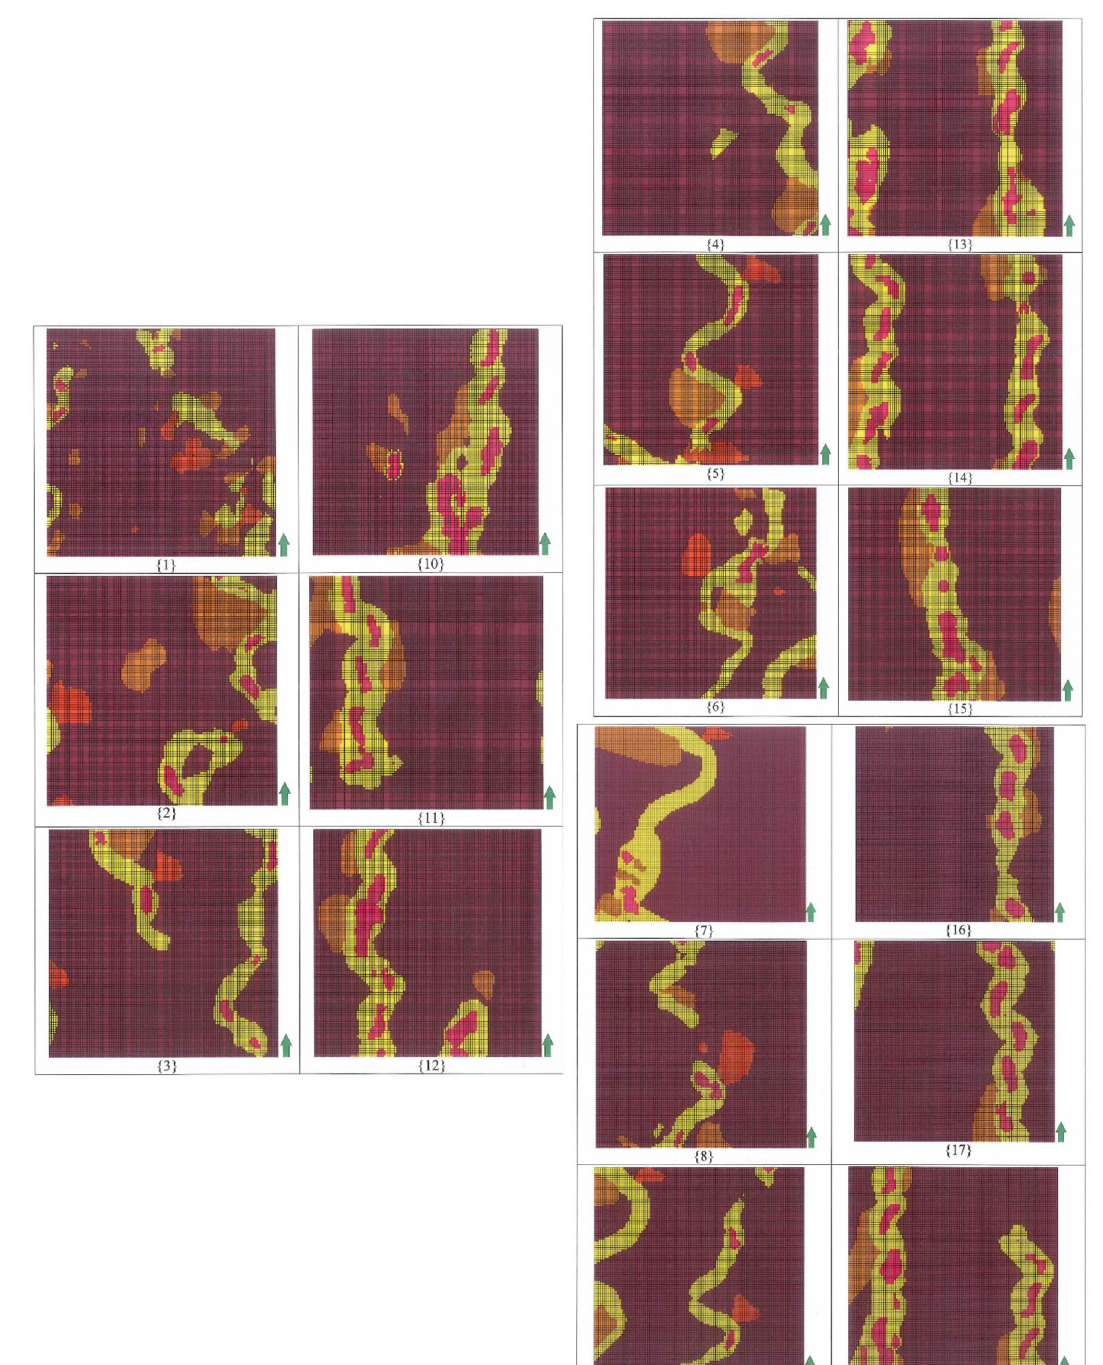
Fig. 19 Unconditional modeling results with different sizes of search